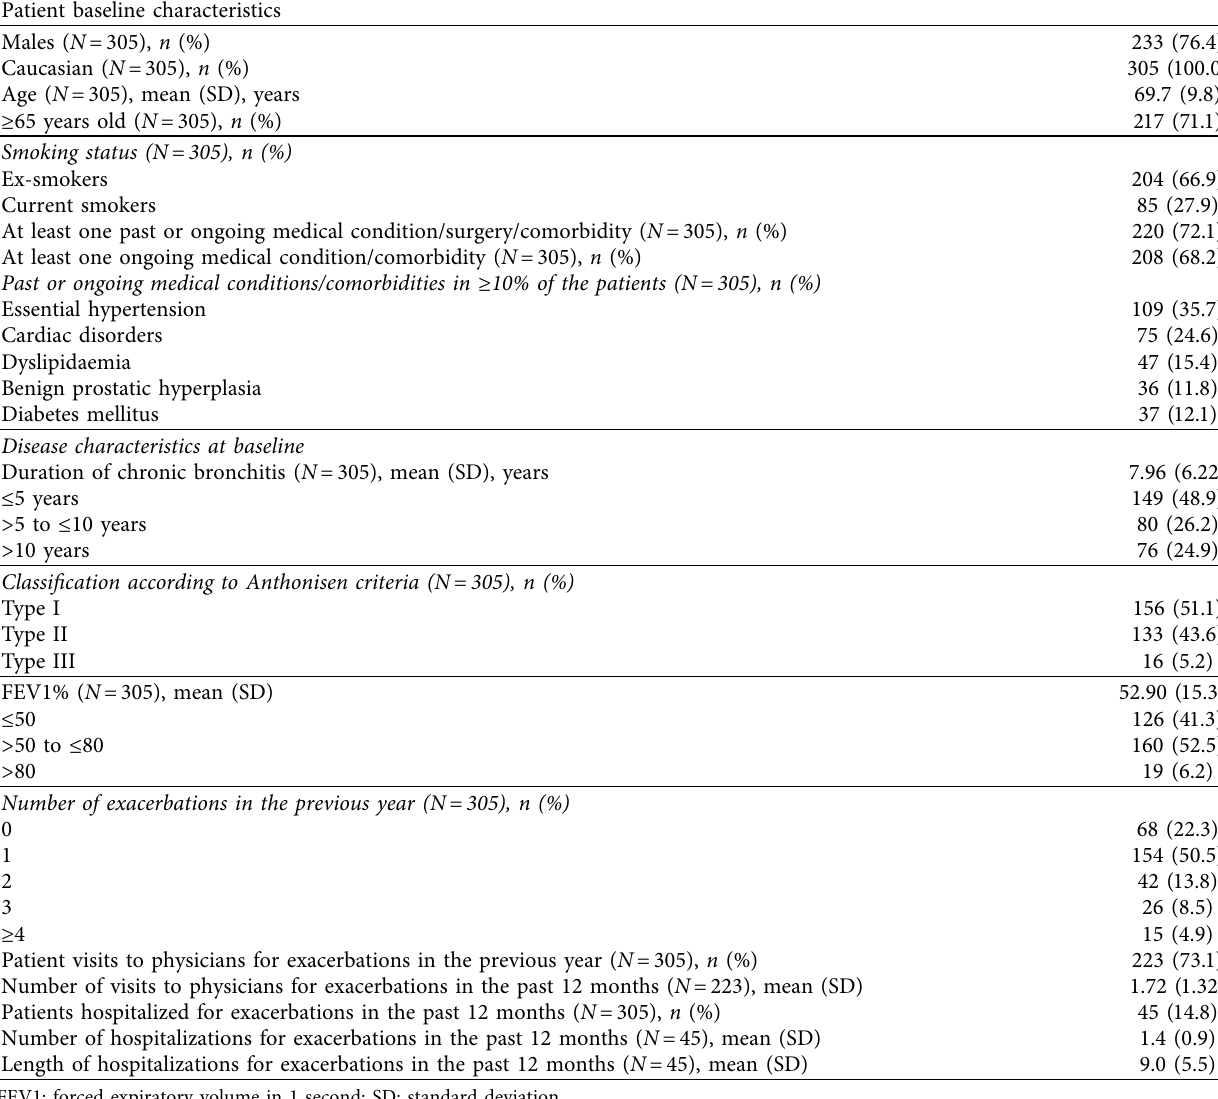
Table 1: Patient and disease characteristics at